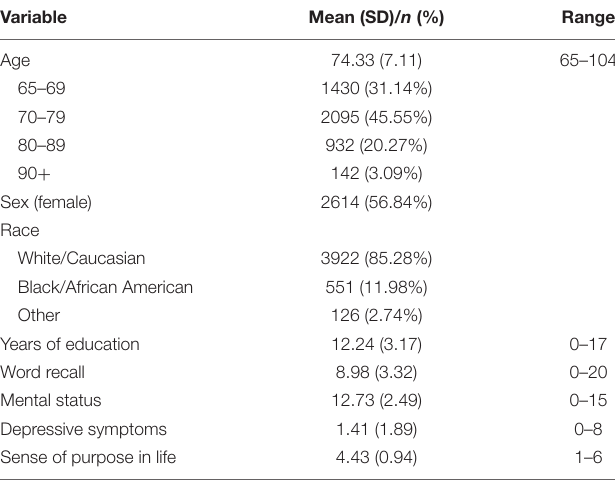
TABLE 1 | Baseline demographic characteristics ( n = 4599).